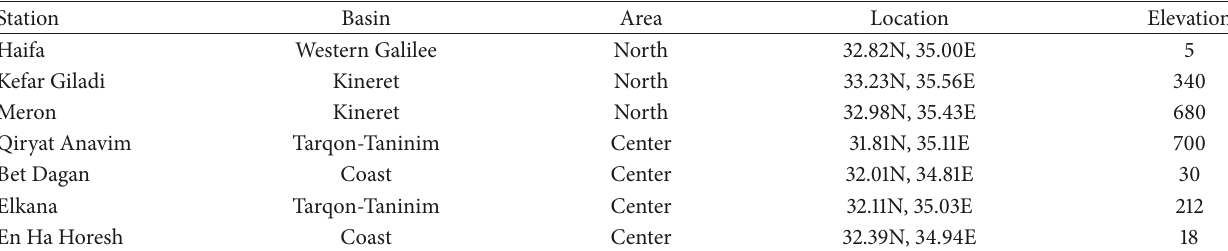
Figure 1: (a) Rain gauges locations and the major Aquifers in Israel: Western Galilee, Kinneret, mountain Aquifer (Yarqon-Taninim), and coastal Aquifer; (b) NMME and ECMWF gird points in the study area. Table 1: The rain gauges